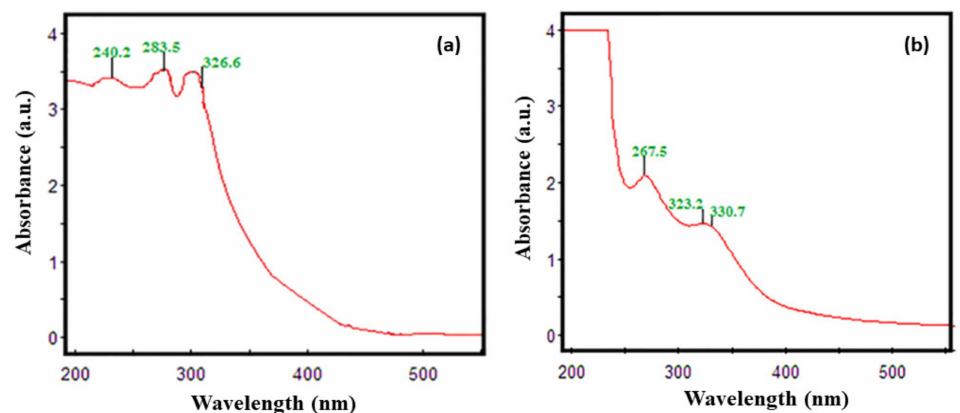
Figure 13. ( a ) UV-visible spectra of aqueous SA-LE and ( b ) the scratched film from mild steel after immersion in 1.0 M HCl with 10% SA-LE